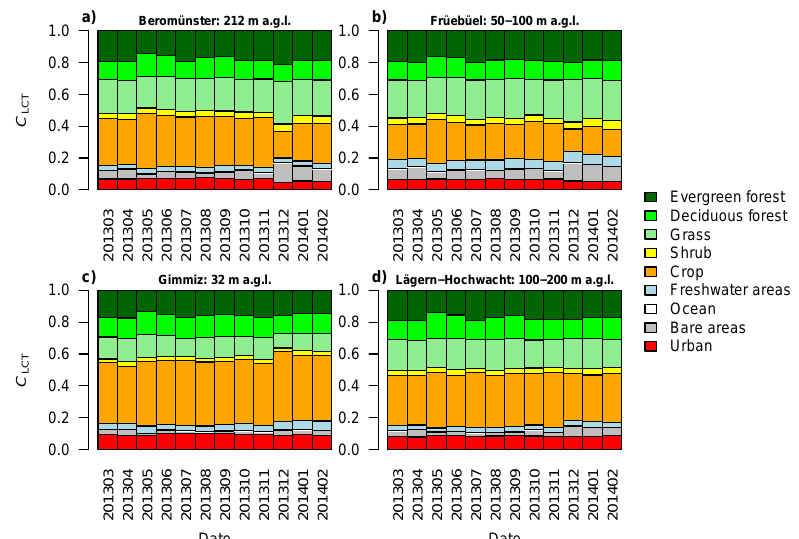
Figure 10. Monthly (YYYYMM) land cover type (LCT) contributions C LCT (Eq. 2) for sites Beromünster (a) , Früebüel (b) , Gimmiz (c) , and Lägern-Hochwacht (d) , calculated as the pixel-wise multiplication of the monthly mean surface sensitivities with the respective LCT fraction and divided by the monthly averaged total surface sensitivities.